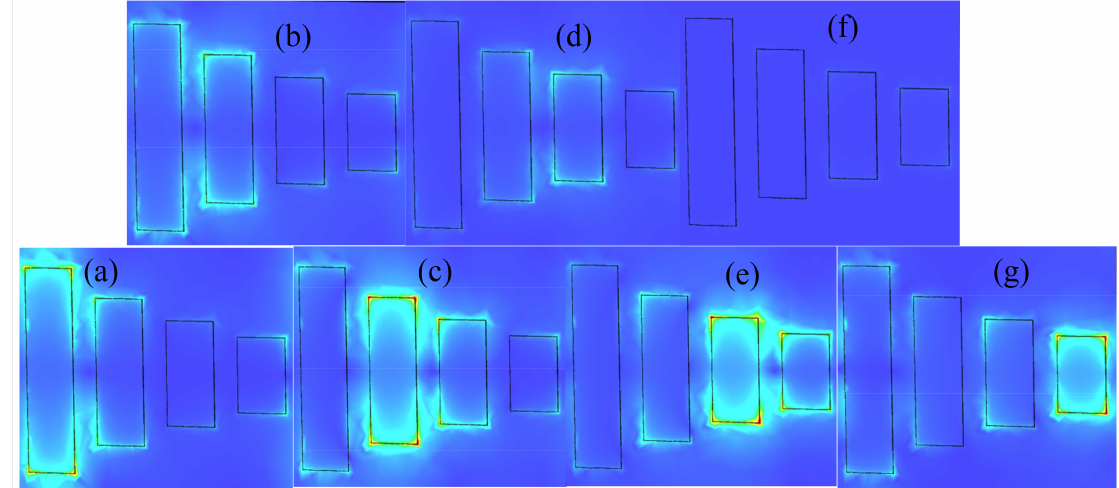
Figure 8. ( a , c , e , g ), ( b , d , f ) The electric field distribution of transmission spectra valleys of ( a , c , e , g ), transmission spectra peaks ( b , d , f ) in Figure 7b on normal incidence,